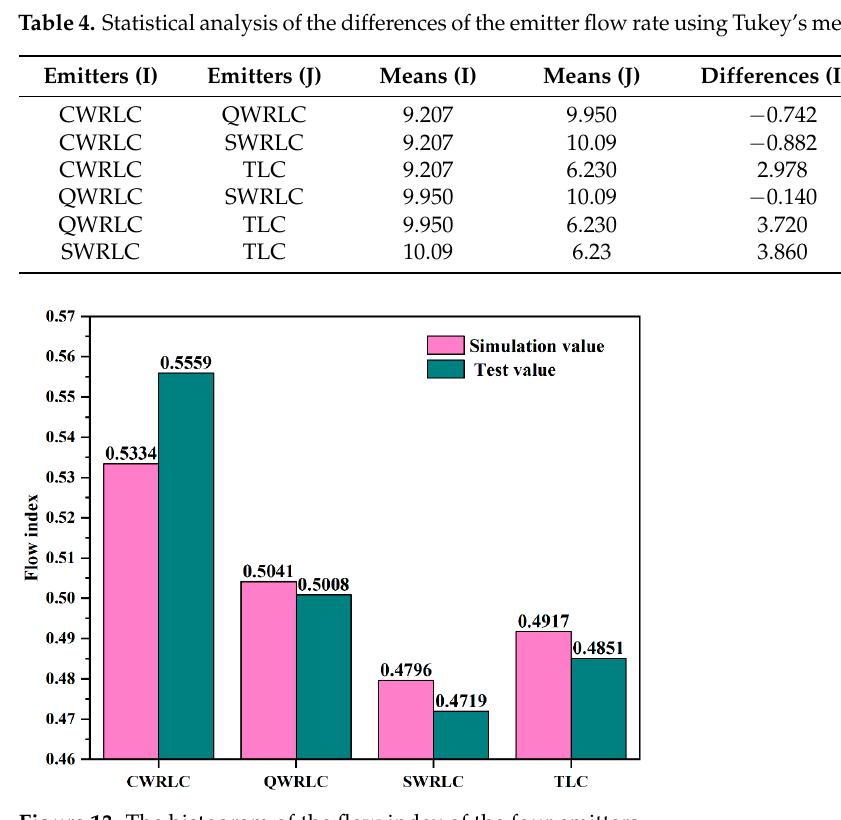
Figure 13. The histogram of the flow index of the four emitters.